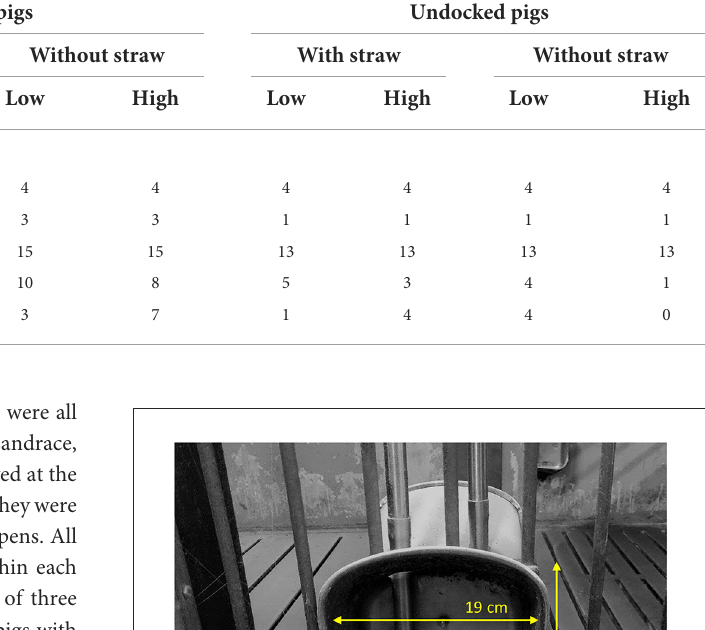
TABLE 1 Number of pens in total and for each batch, number of pens that were never scored with a tail damage event (“no tail damage” pens) and number of tail damage pairs within each treatment combination of docked and undocked pigs, with and without straw and with low (1.21 m 2 /pig) and high (0.73 m 2 /pig) stocking density.